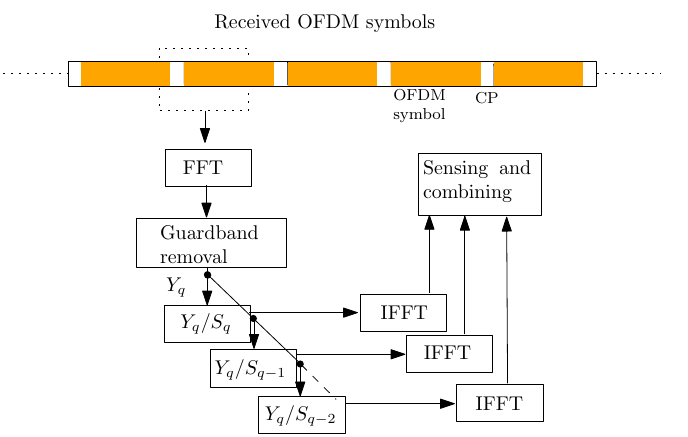
Figure 3. Schematic of the proposed range extension method to detect targets beyond the range limit in the conventional OFDM–based